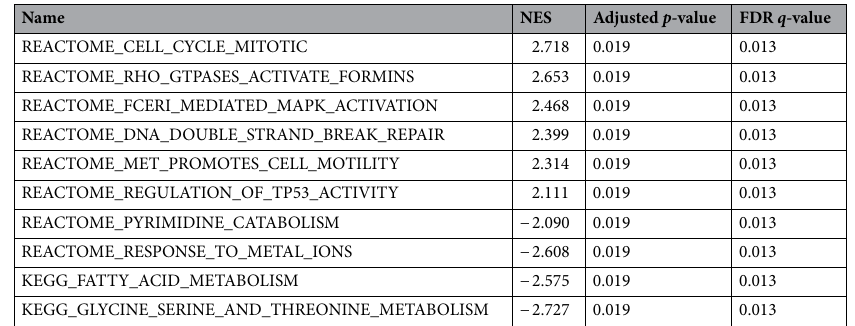
Table 2. Pathways enriched in high expression groups using GSEA. FDR false discovery rate, NES normalized enrichment score.